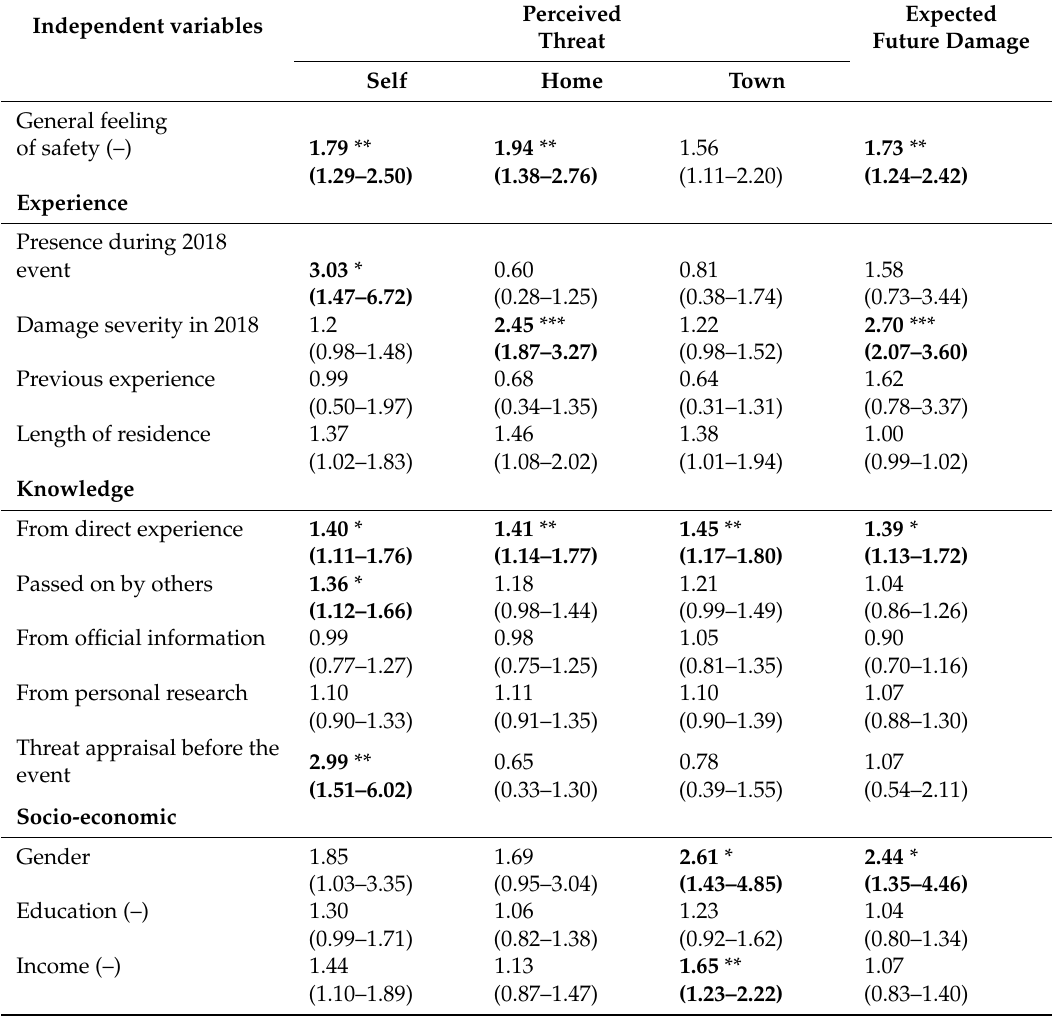
Table 3. Odds Ratios resulting from the single